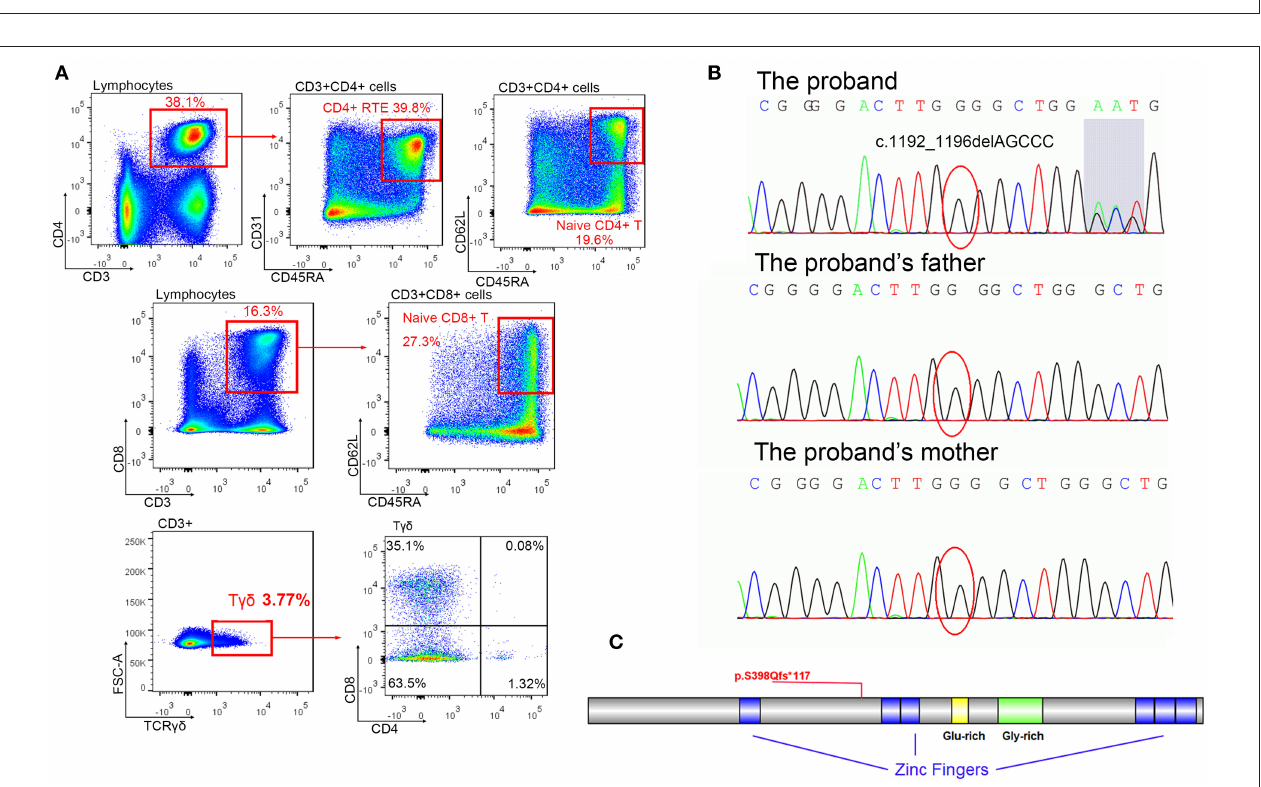
FIGURE 2 | The mutation of BCL11B . (A) Immune cell analysis of the patient indicated lymphopenia. (B) Mutation c.1192_1196delAGCCC was only identified in a patient (shadow shows the chaos of subsequent sequence), but her parents displayed regular sequences. (C) The schema of the BCL11B gene with the frameshift mutation of this